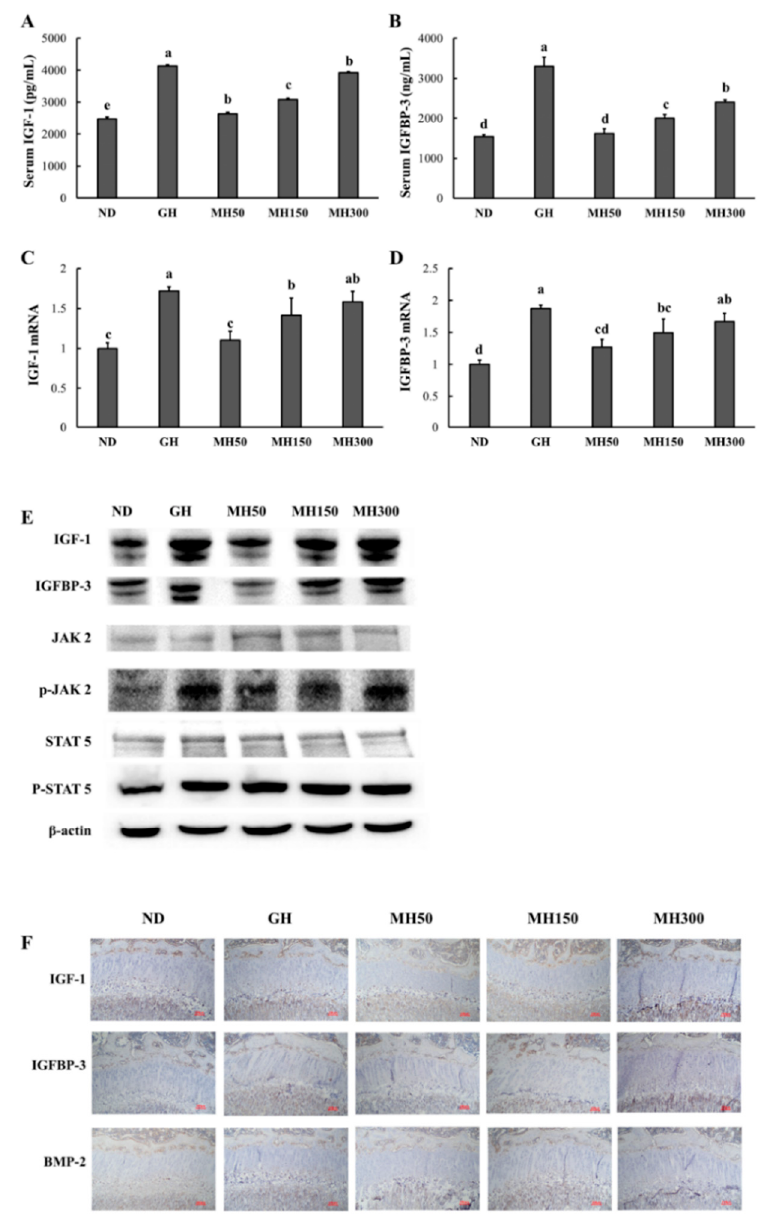
Figure 5. The effect of dietary administration of a mixture of H. japonicus (MH) on serum insulin-like growth factor-1 (IGF-1) ( A ), serum IGF binding protein-3 (IGBBP-3) ( B ), IGF-1 mRNA in the liver ( C ), growth factor-1 (IGF-1) ( A ) serum IGF binding protein-3 (IGBBP-3); ( B ) IGF-1 mRNA in the liver; ( C ) IGFBP-3 mRNA in the liver ( D ),protein expression of IGF-1, IGFBP-3, JAK2, p-JAK2, STAT5, and IGF binding protein-3 (IGFBP-3) mRNA in the liver; ( D ) protein expression of IGF-1, IGFBP-3, JAK2,